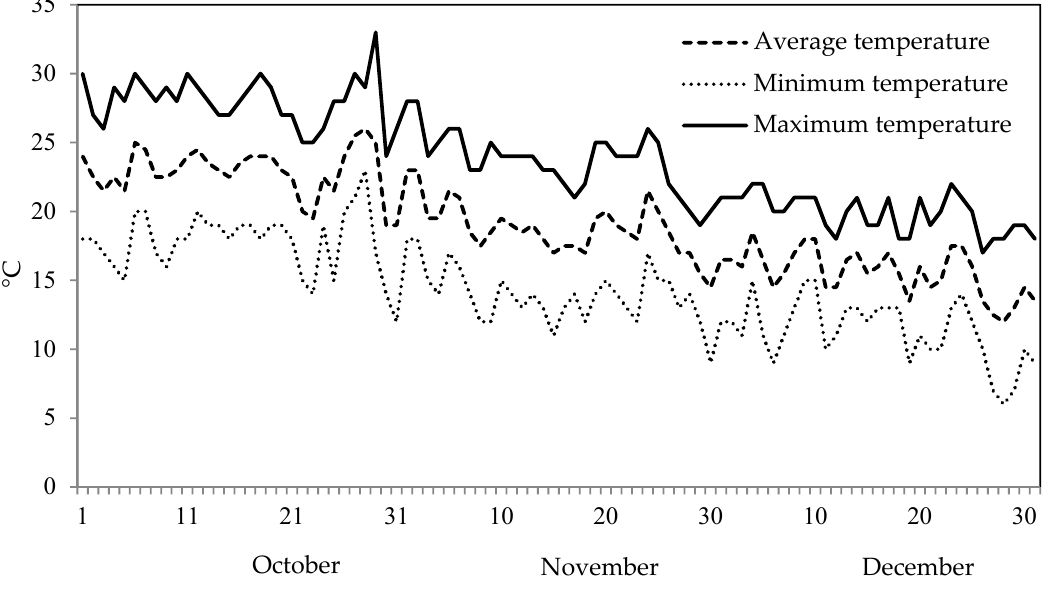
Figure 2. Maximum, minimum, and average temperatures during the forcing periods.